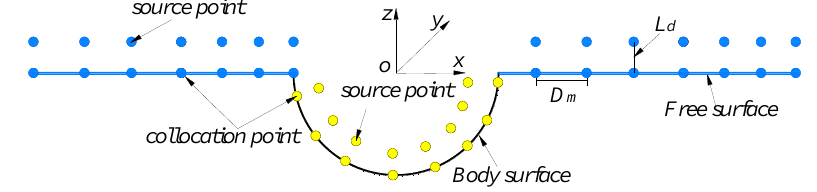
Figure 2. Desingularized Rankine panel model.